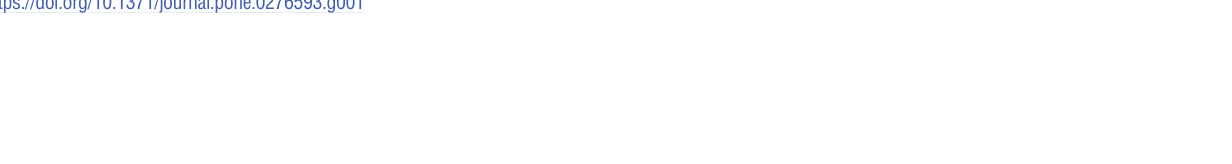
PLOS ONE | https://doi.org/10.1371/journal.pone.0276593 February 3,